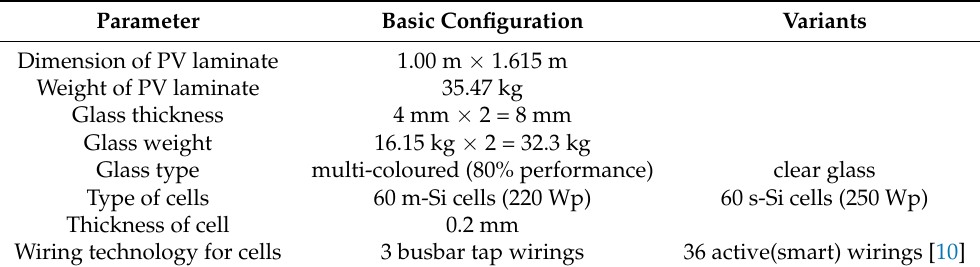
Table 2. Typical specifications of a photovoltaic laminate considered in this